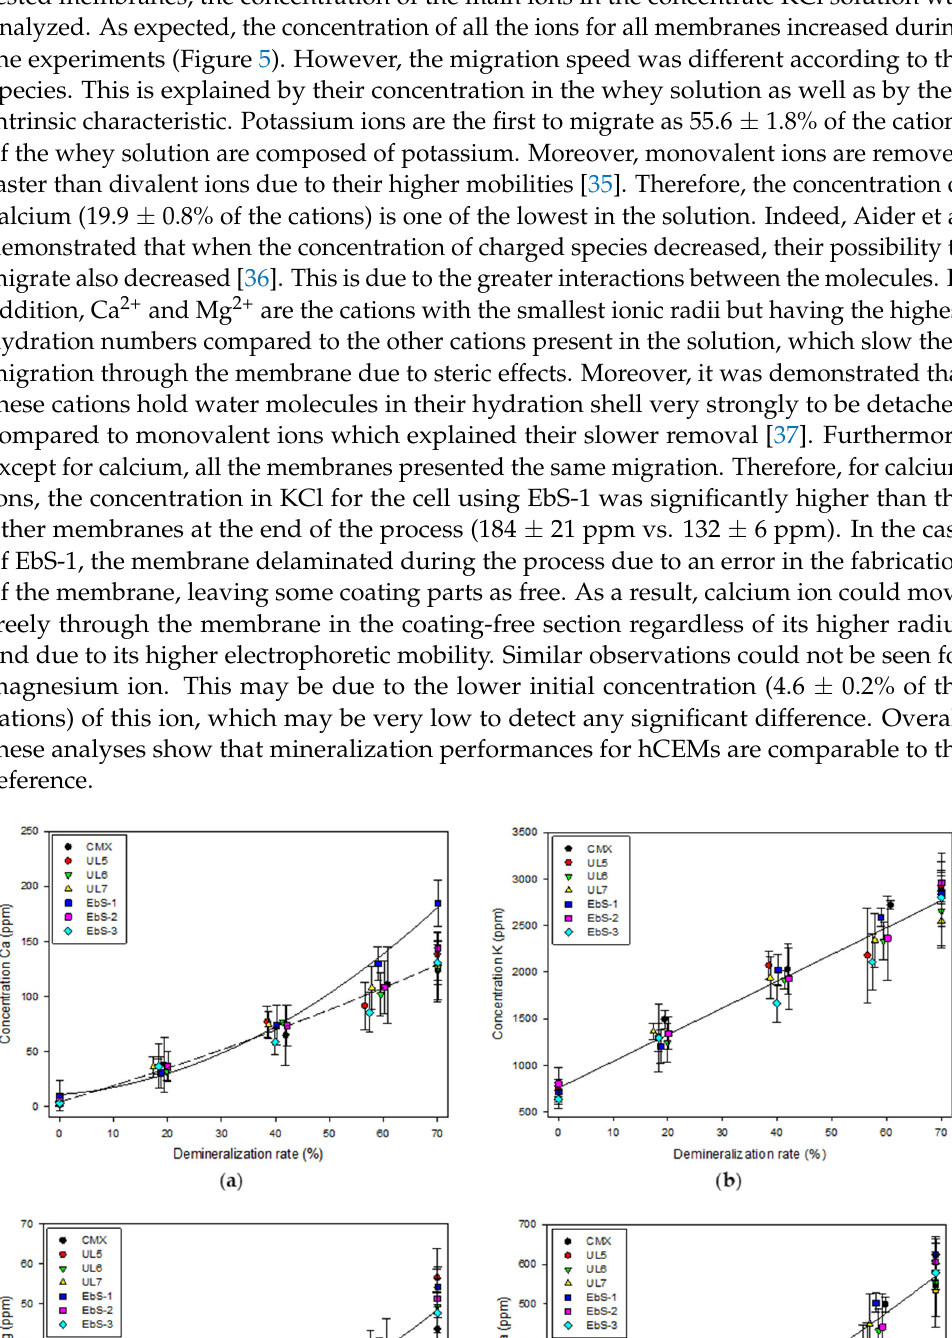
Figure 5. Concentration of ions in the concentrate compartment during electrodialysis as a function of the demineralization rate: ( a ) Calcium; ( b ) potassium; ( c ) magnesium; ( d ) sodium; ( e ) phospho- rous; ( f ) chloride.